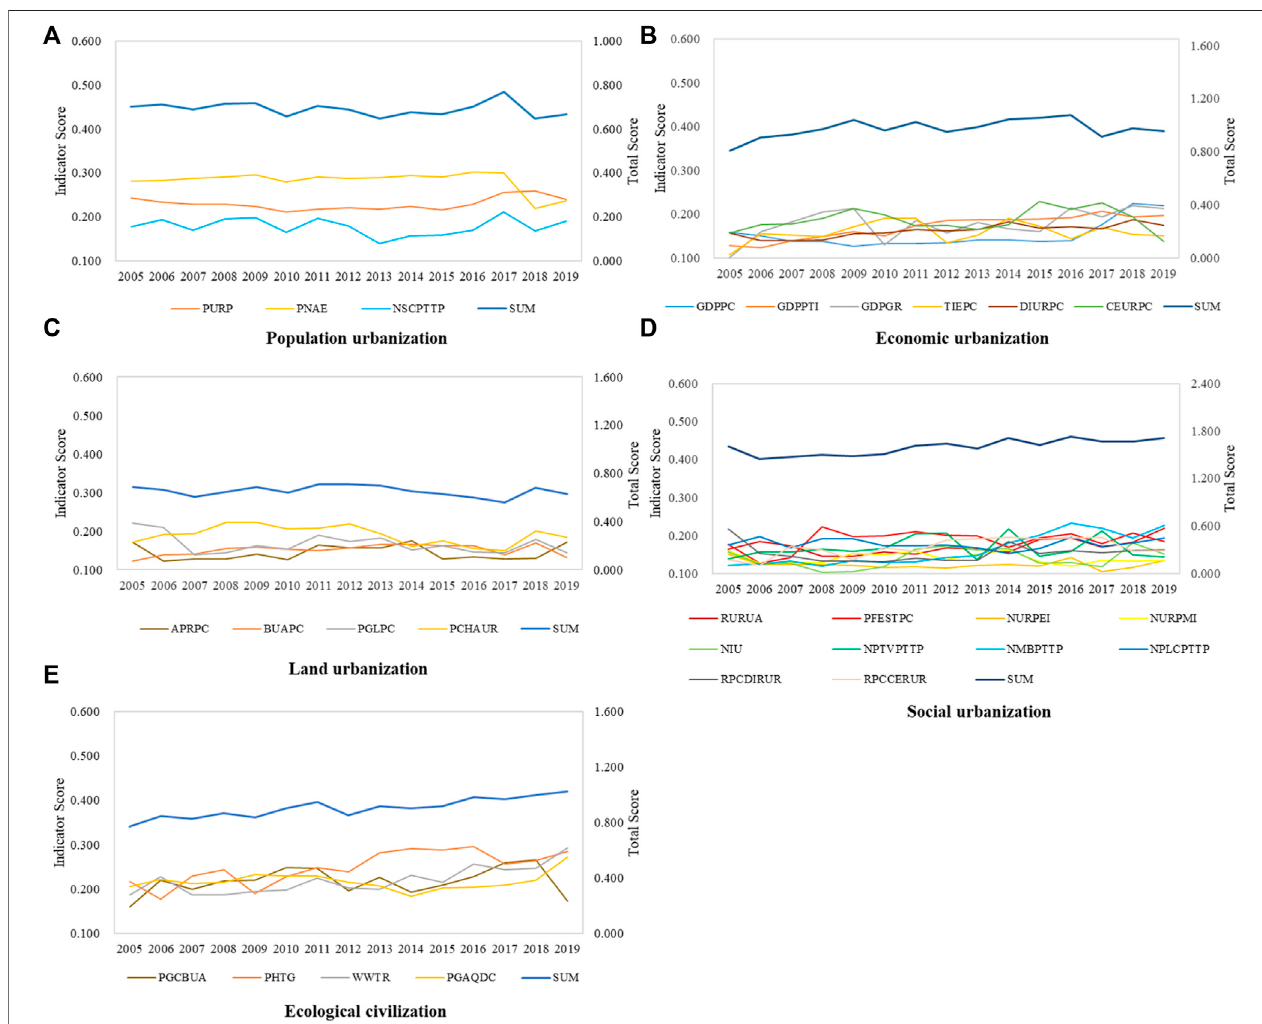
FIGURE6| Thescoresofthefactorlayersofallcitiesfrom2005to2019. (A) Populationurbanization. (B) Economicurbanization. (C) Landurbanization. (D) Social urbanization. (E) Ecological civilization.